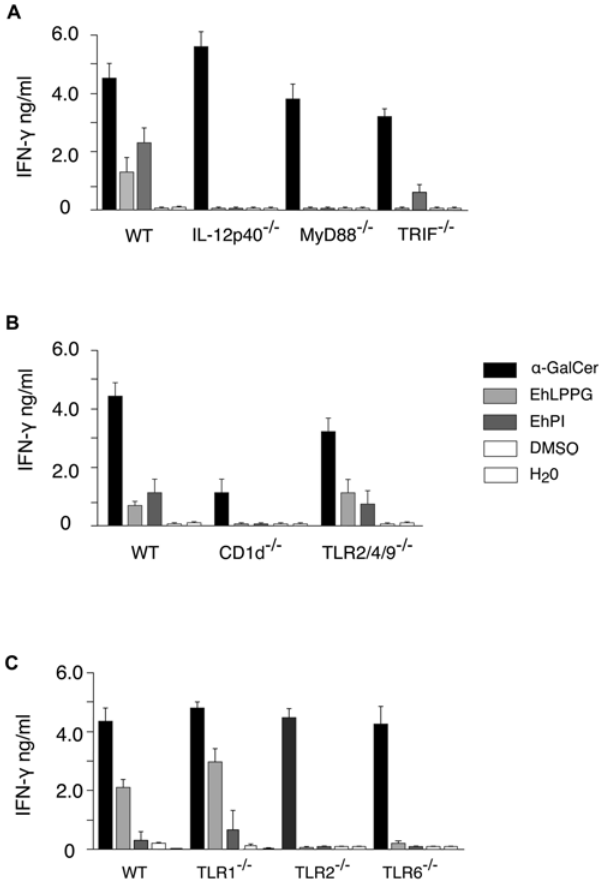
Figure 6. Activation of NKT cells by EhLPPG involves molecules of the TLR signalling pathway. APC from IL12-p40 2 / 2 , MyD88 2 / 2 , TRIF 2 / 2 (A), CD1d 2 / 2 , TLR2 2 / 2 , 4 2 / 2 , 9 2 / 2 (B), and TLR1 2 / 2 , 2 2 / 2 and 6 2 / 2 (C) were generated, pulsed with EhLPPG and used to stimulate purified T cells from V a 14tg mice. The production of IFN- c by purifed T cells was determined by ELISA. EhLPPG-dependent NKT cell activation was abrogated in CD1d 2 / 2 , IL-12p40 2 / 2 , MyD88 and TLR 2 2 / 2 and TLR 6 2 / 2 mice. The results were obtained from two independent